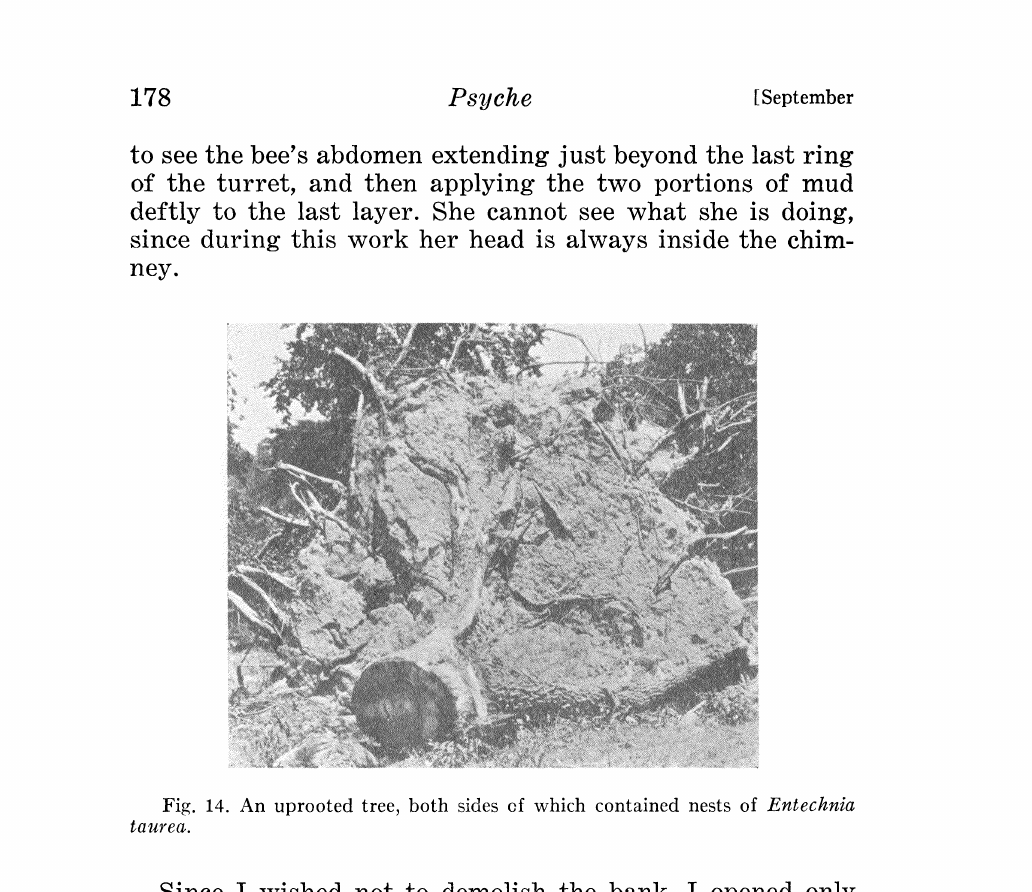
Fig. 14. An uprooted tree, both sides cf which contained nests of Entechnia